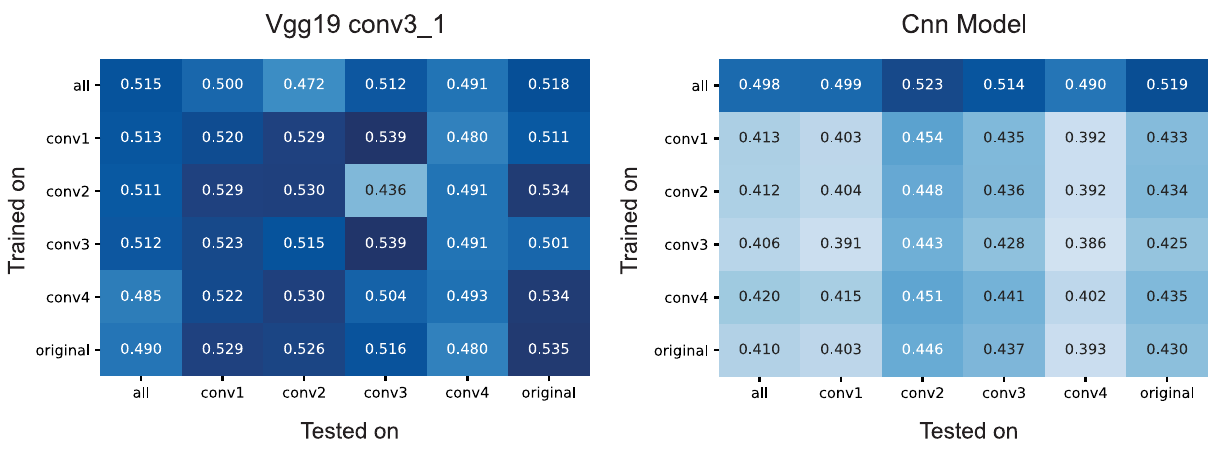
Fig 10. Training and evaluation on the different stimulus types. For both conv3_1 features of VGG-19 (left) and CNN-based models, we trained with all and every individual stimulus type (rows) (see Fig 1) and tested on all and every individual type. The VGG model showed good domain transfer in general. The same was true for the data-driven CNN model, although it performed worse overall when trained on only one set of images due to the smaller training sample. There were no substantial differences in performance across image statistics.